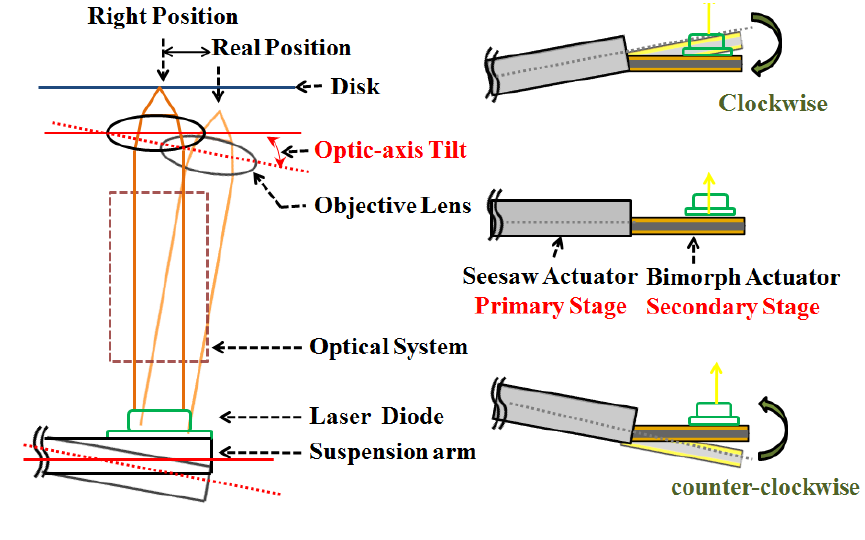
Figure 3. Conceptual diagram of the combined bimorph piezo-VCM actuator based active tilt compensation.